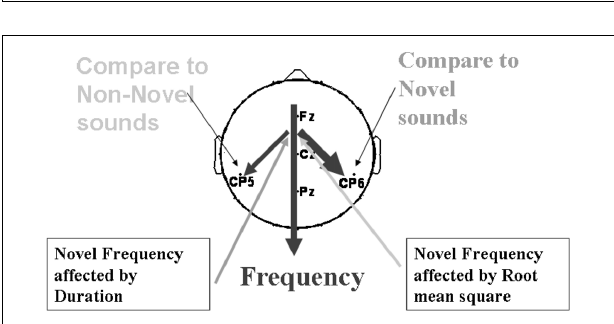
FIGURE 10 | Initial hypothesis plotted with the first results and the route to the sound properties analysis. (A) Theory of habituation response to stimulus sequence. (B) Initial hypothesis about time dependence of novel amplitude. Found only in some left electrodes in controls. (C) Most of the amplitude channels explained by significant correlations with stimulus properties in both